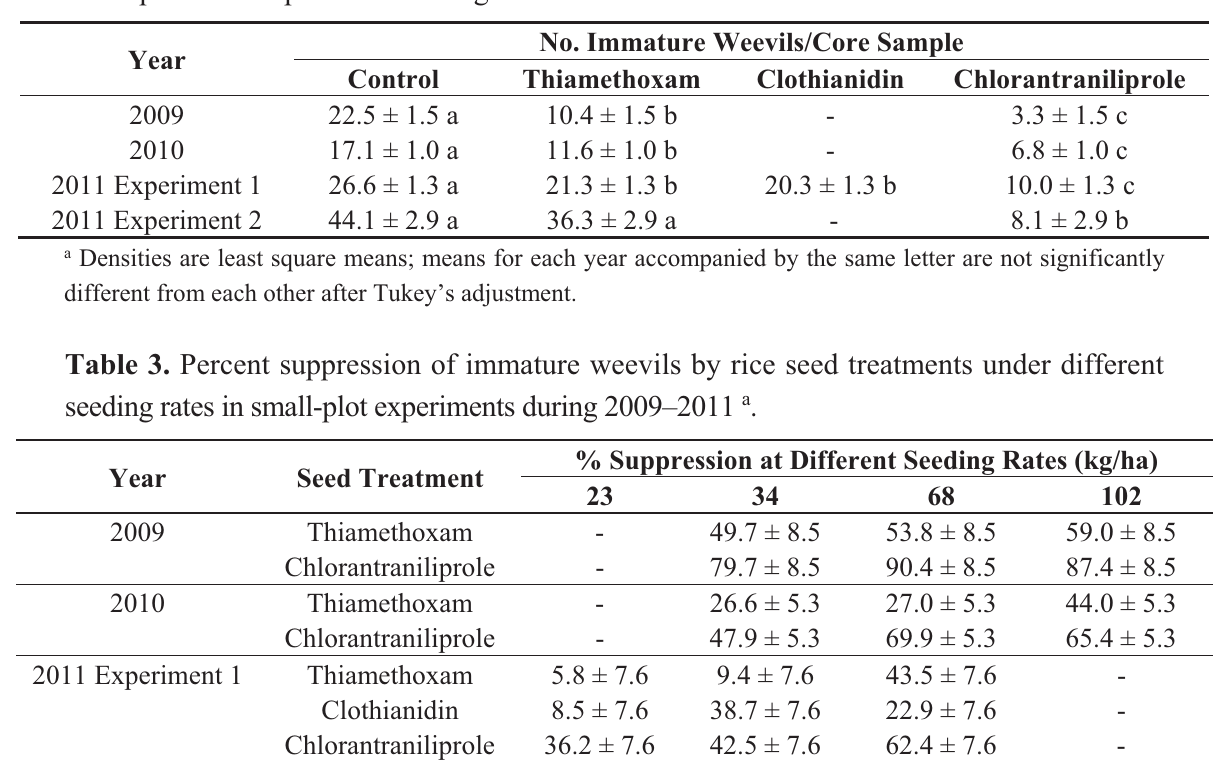
Table 2. Impact of insecticidal treatment as a main effect on immature weevil densities in small-plot field experiments during 2009–2011 a .